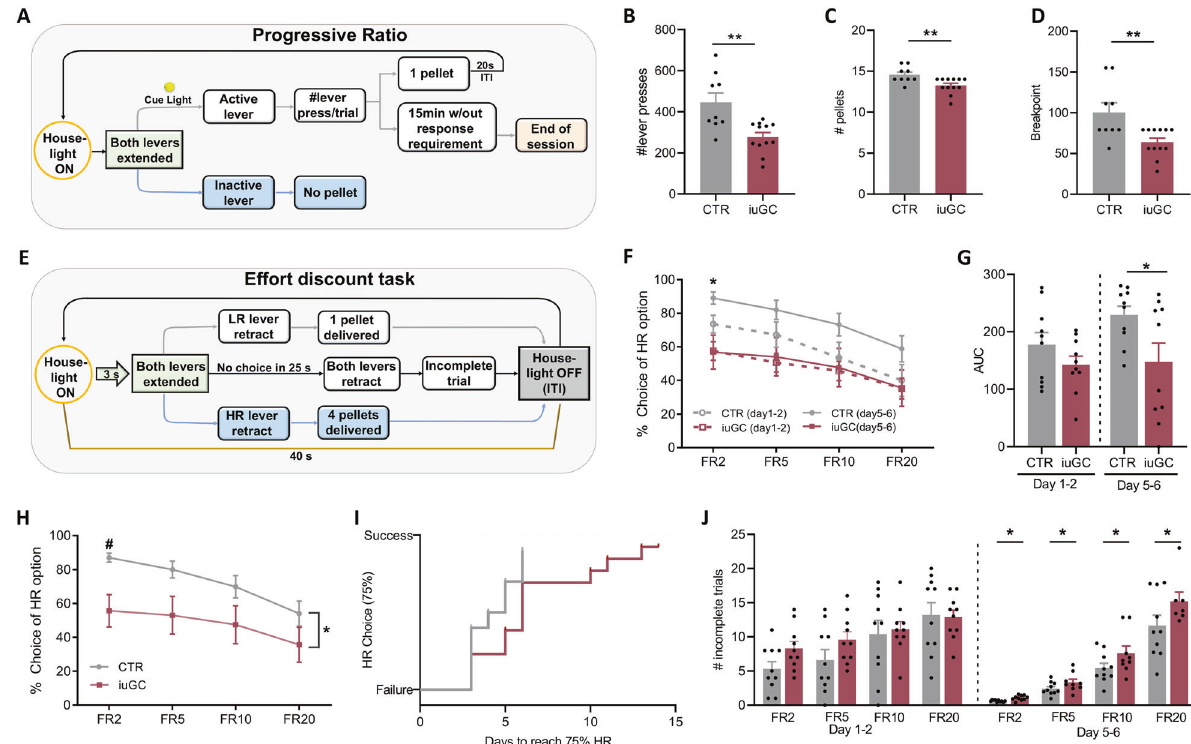
Fig. 1 iuGC exposure impairs motivated behavior. A Progressive Ratio task scheme. B Total number of lever presses during PR test ( n CTR = 9, n iuGC = 12). C Total number of pellets received in PR test session. D Animal ’ s breakpoint in the PR test. E Effort-discounting task scheme. F Percentage of HR preference during early learning (day 1 and 2) and late learning (day 5 and 6) during the effort-based task; * indicates difference between iuGC and CTR in FR2 in late learning ( n CTR = 10, n iuGC = 10). G Area under the curve for early learning and late learning. H Percentage of HR preference when animals ful fi ll the criteria of the test (75% of HR preference in FR2). I Success curve representing the time that each group required to ful fi ll the criteria of the test. J Number of incomplete trials during early and late learning. Error bars denote SEM. *or # p ≤ 0.05; ** p ≤